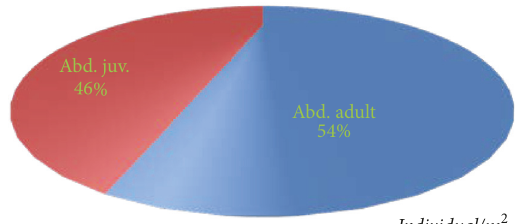
Figure 7: Total abundance percentage of earthworms in study sites.